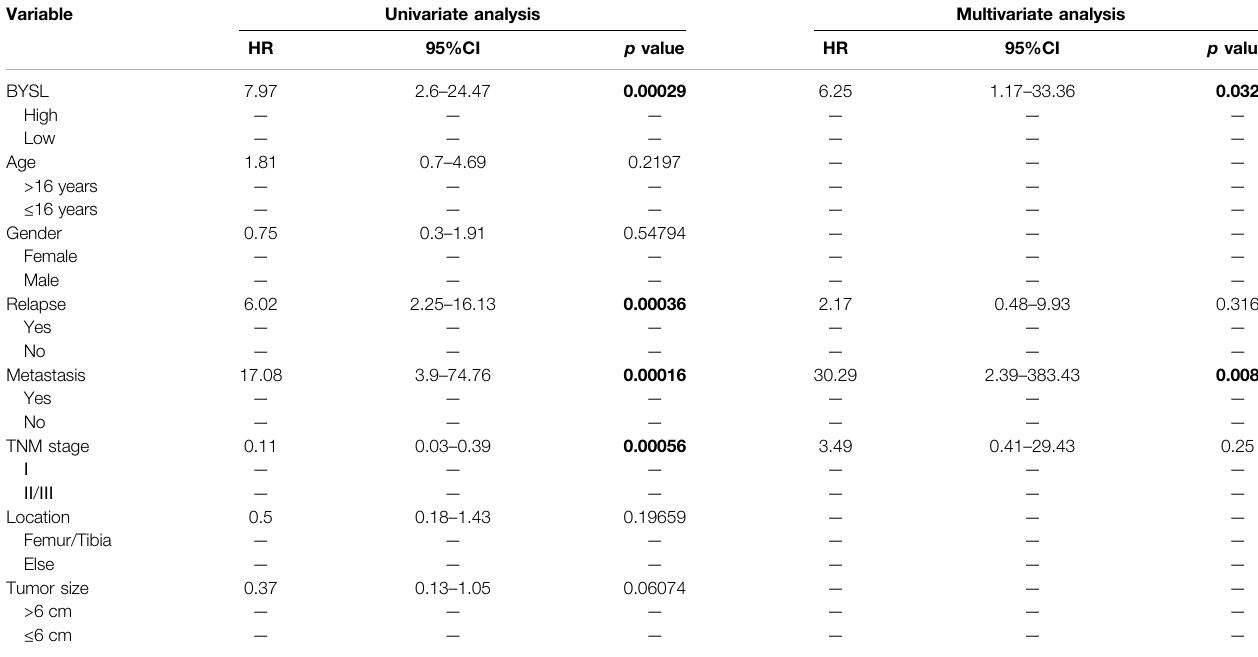
TABLE 2 | Univariable and multivariable Cox regression analysis of clinical characteristics and BYSL in osteosarcoma. Variable